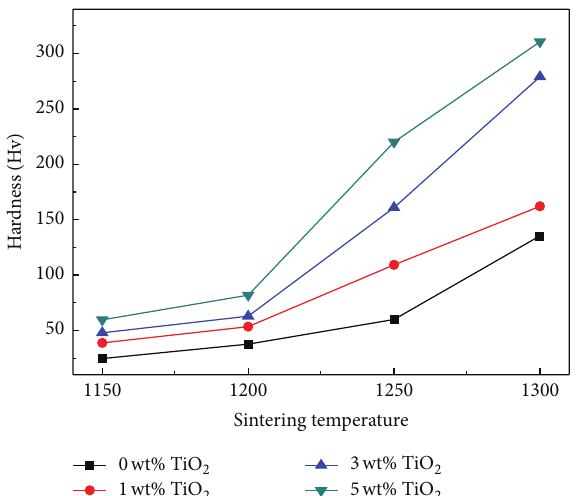
Figure 6: Vickers hardness of the ZrO 2 ceramics with addition of 0, 1, 3, and 5wt% TiO 2 contents under different sintering temperatures.